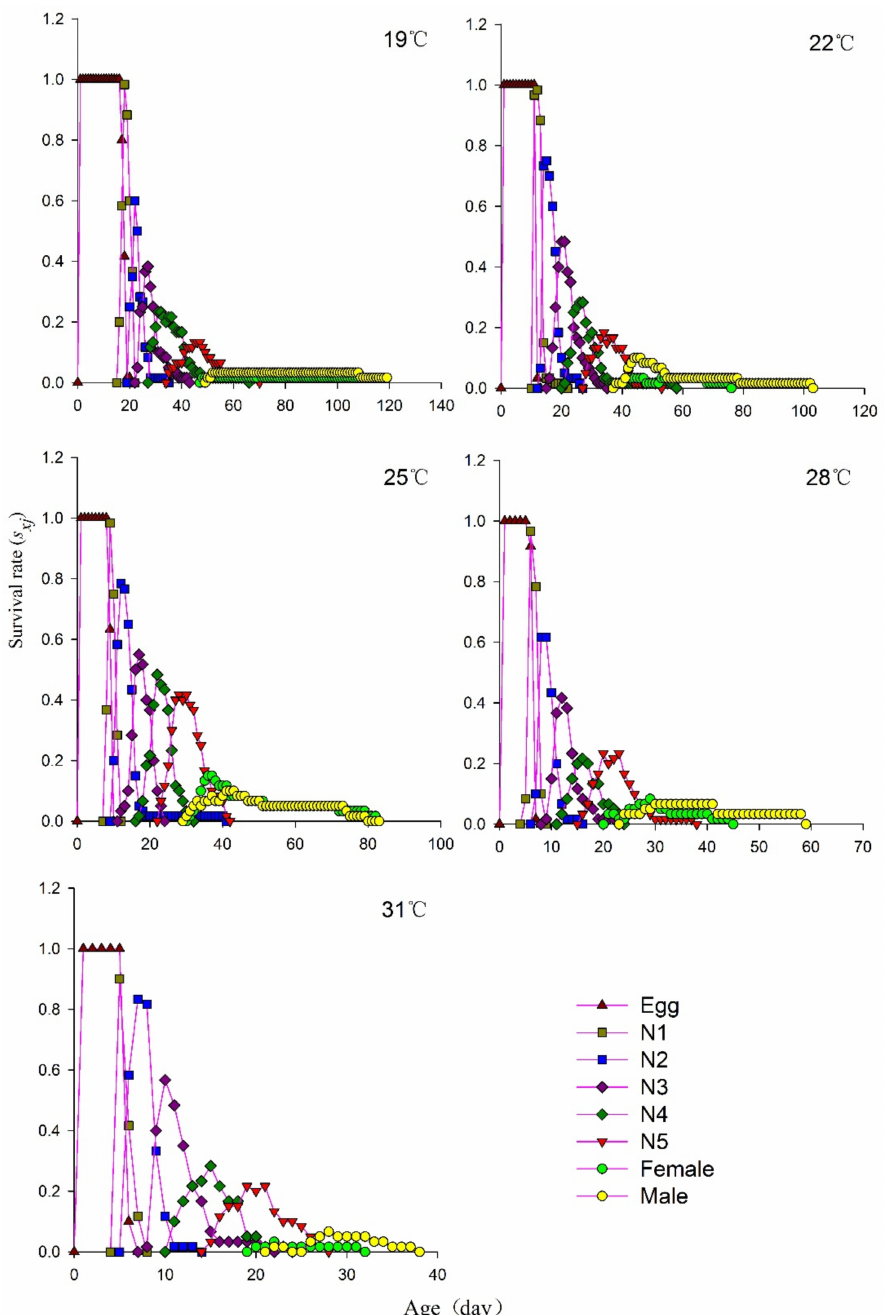
Figure 2. Age–stage-specific survival rates ( s xj ) of R. pedestris at different temperatures. Note: N1–N5 represent first, second, third, fourth, and fifth instars,